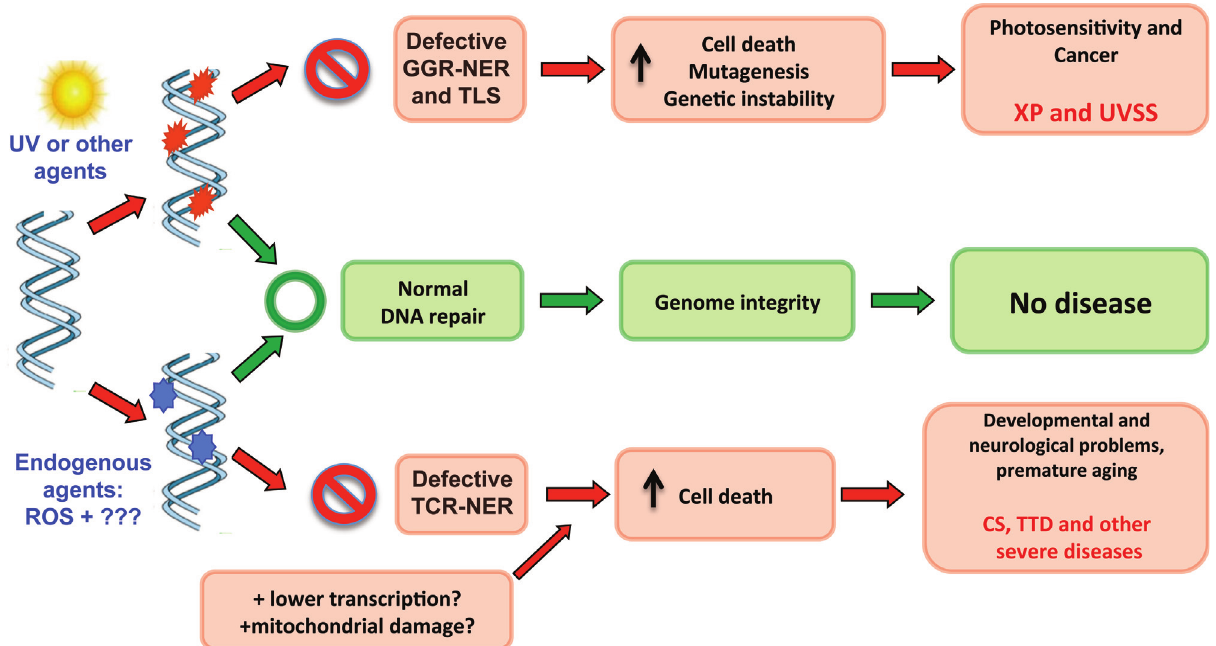
Figure 4 - The consequences of DNA damage and how defective NER and TLS may explain certain clinical phenotypes. Different types of DNA damage can be induced by a variety of endogenous and exogenous agents. NER removes several of these lesions and TLS helps to replicate them, aiming mainte- nance of the genome stability, and guaranteeing normal cell proliferation, and normal human life (represented in green). When these mechanisms fail, er- rors in DNA replication increase mutagenesis and genetic instability, resulting in higher photosensitivity (observed in UVSS and XP patients) and risk of cancer development (observed in XP patients). Defective GGR-NER and TLS better explain these phenotypes (in red, superior part of the figure). Alter- natively, endogenous DNA damage (including those induced by ROS) may disturb the transcription and/or cause replication blockage, leading to cell death,thusdefectiveTCR-NERbetterexplainthemoreseverephenotypes(includingprematureaging)ofXP/CS,CSandothersyndromes.Othereffects, such as impaired transcription or damaged mitochondria may also be involved in these phenotypes (in red lower part of the